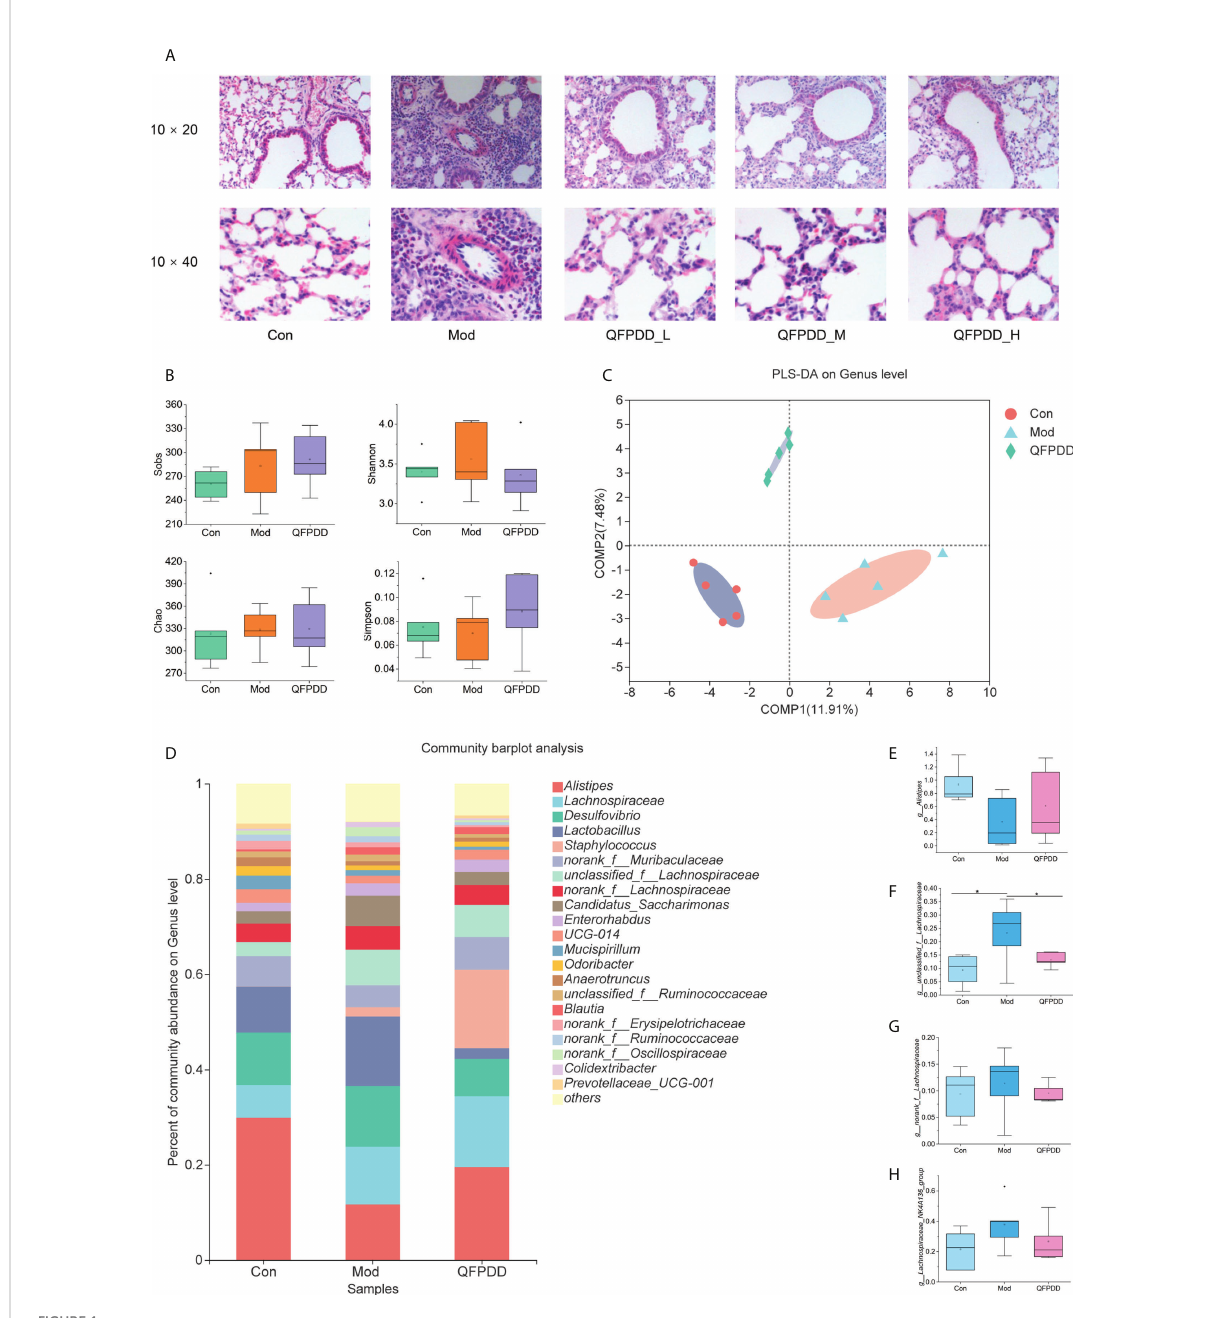
FIGURE 1 Pathological alterations, gut microbiome diversity,and structural analysis. (A) Effectof different doses of Qing-Fei-Pai-Du decoction(QFPDD) onlung histopathology. (B) Species diversity differences between the Con, Mod, and QFPDD groups wereestimated by the observed species, Sobs, Chao, Shannon, Simpson. (C) Supervised partial least squares discriminant analysis (PLS-DA) showingthe discrimination betweenthe samplegroups. (D) Bacterial taxonomic pro fi lingin thegenus level of gutmicrobiotain theCon, Mod, andQFPDD groups. (E – H) Box plots of relative abundance changes of Alistipes , unclassi fi ed_f_Lachnospiraceae , norank_f_Lachnospiraceae , and Lachnospiraceae_NK4A136_group inCon, Mod, andQFPDD, * p <